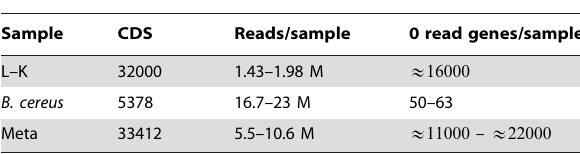
Table 1. Sample characteristics